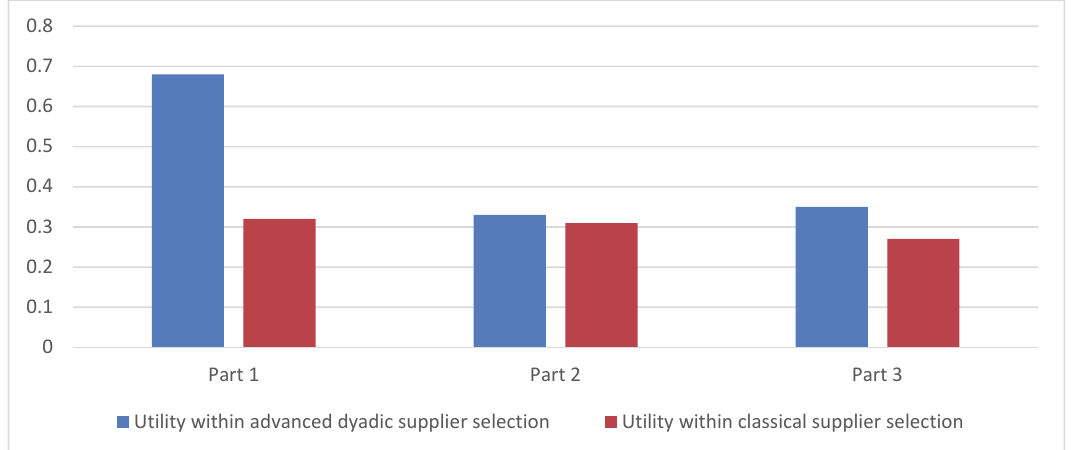
Fig. 12. Utility comparison between the proposed dyadic negotiation protocol and a classical negotiation protocol for supplier